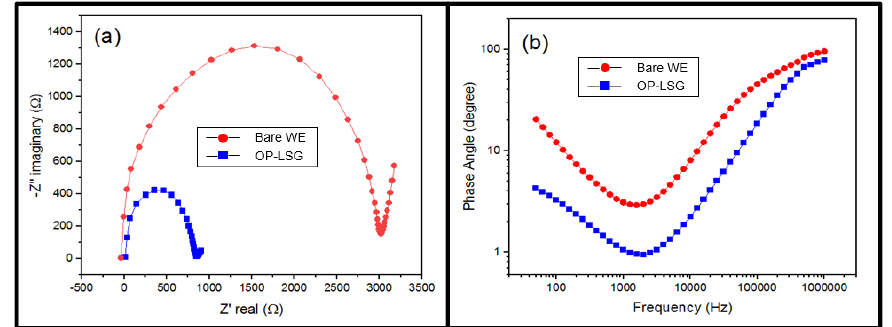
Fig. 5. Electrochemical Impedance Spectroscopy of OP-LSG versus bare carbon Working Electrode. (a), Nyquist plot (b), Phase angle versus frequency